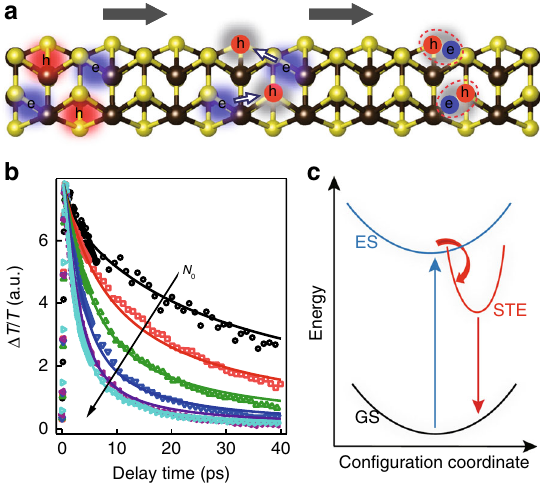
Fig. 4 Self-trapping process. a Scheme showing two-step formation process of STEs in Sb 2 S 3 : hole is self-trapped fi rst and then electron is captured by trapped hole to form STE. b Carrier-trapping kinetics (open symbols) under different photoexcited carrier densities N 0 (5 × 10 18 cm − 3 to 1.2 × 10 20 cm − 3 ) for Sb 2 S 3 single-crystal fl ake and their fi ts to two-step formation mechanism (solid lines). c Qualitative adiabatic potential energy curve showing photoexcitation from ground state (GS) to excited state (ES), which further evolves into STE state by deforming lattice and losing substantial